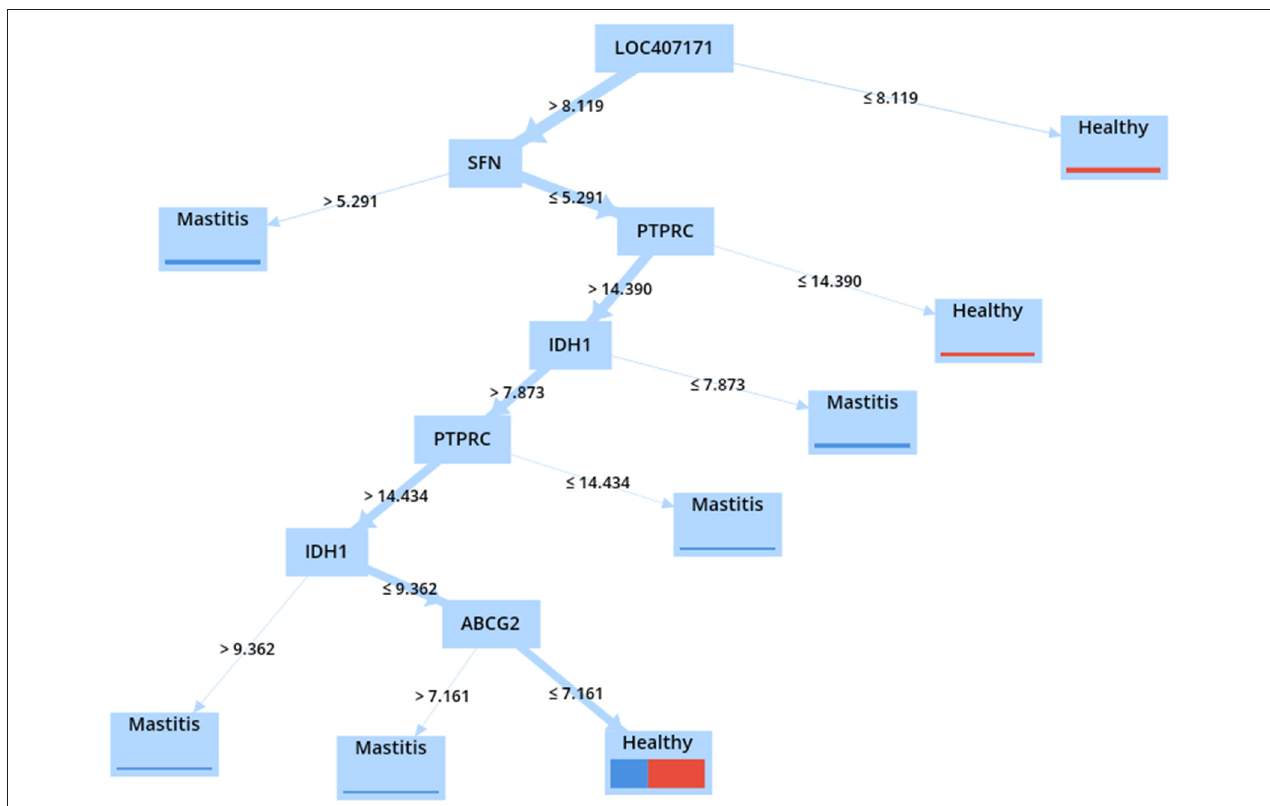
FIGURE 8 | DT model using gain ratio criterion in healthy and mastitis